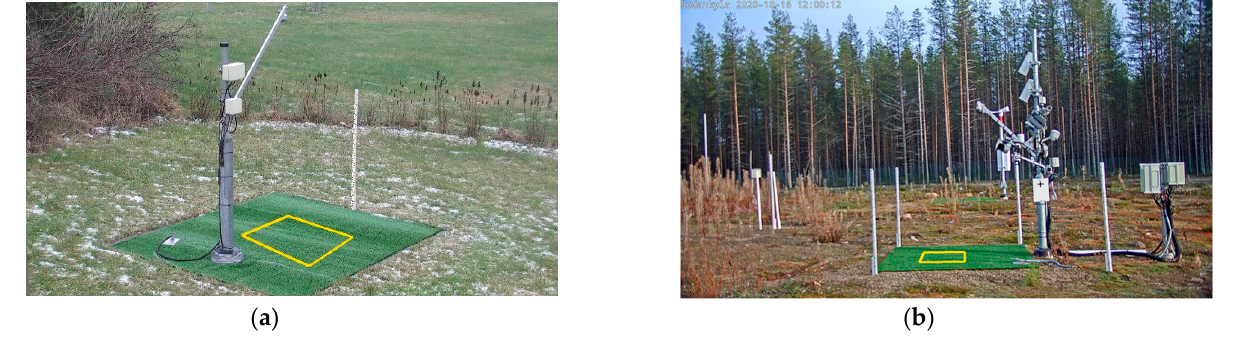
Figure 2. Web camera images of weather station setups in ( a ) Jokioinen and ( b ) Sodankylä. The areas with yellow marking are the chosen ROIs.